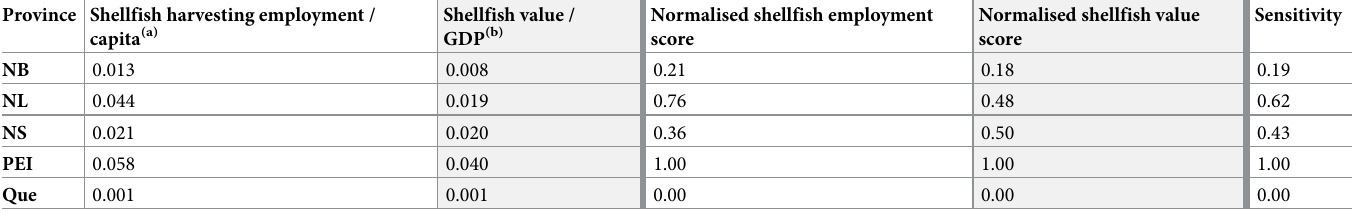
Table 3. Indicators scores for sensitivity. Columns 2–3 present absolute scores for each province while columns 4–5 present the corresponding normalised scores as used to calculate provincial sensitivity (column 6). Higher sensitivity scores contribute to higher potential impact. The sensitivity scores were combined with the adaptive capacity scores (as indicated in Fig 4) in Table 4 to define vulnerability for each province (Table 5).